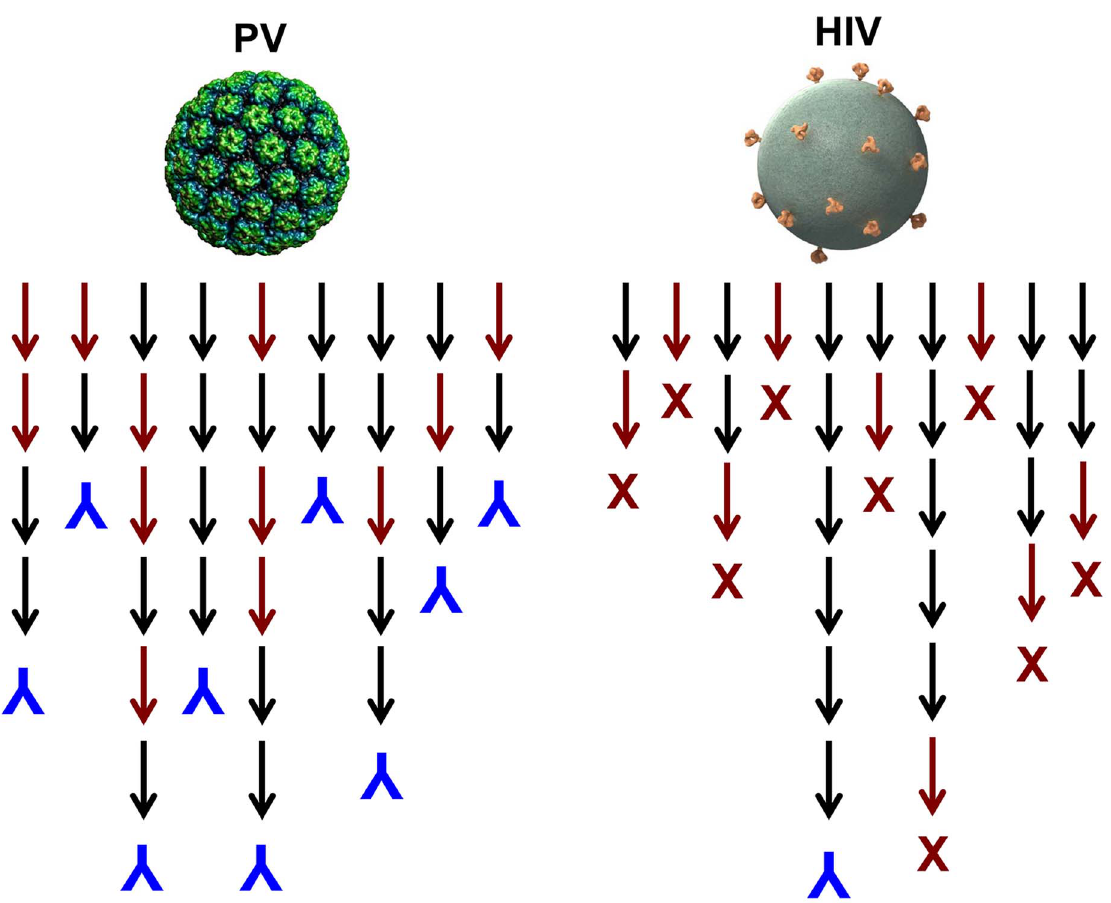
Figure 2. Model for the induction of neutralizing antibodies by high-density versus low-density epitope display. Black arrows represent antibody species during lineage evolution that are not reactive with self; red arrows represent species that are reactive with self. Inverted blue Ys denote B cell lineages that result in production of a virion binding antibody; red Xs denote deletion or tolerization of a self-reactive B cell lineage.